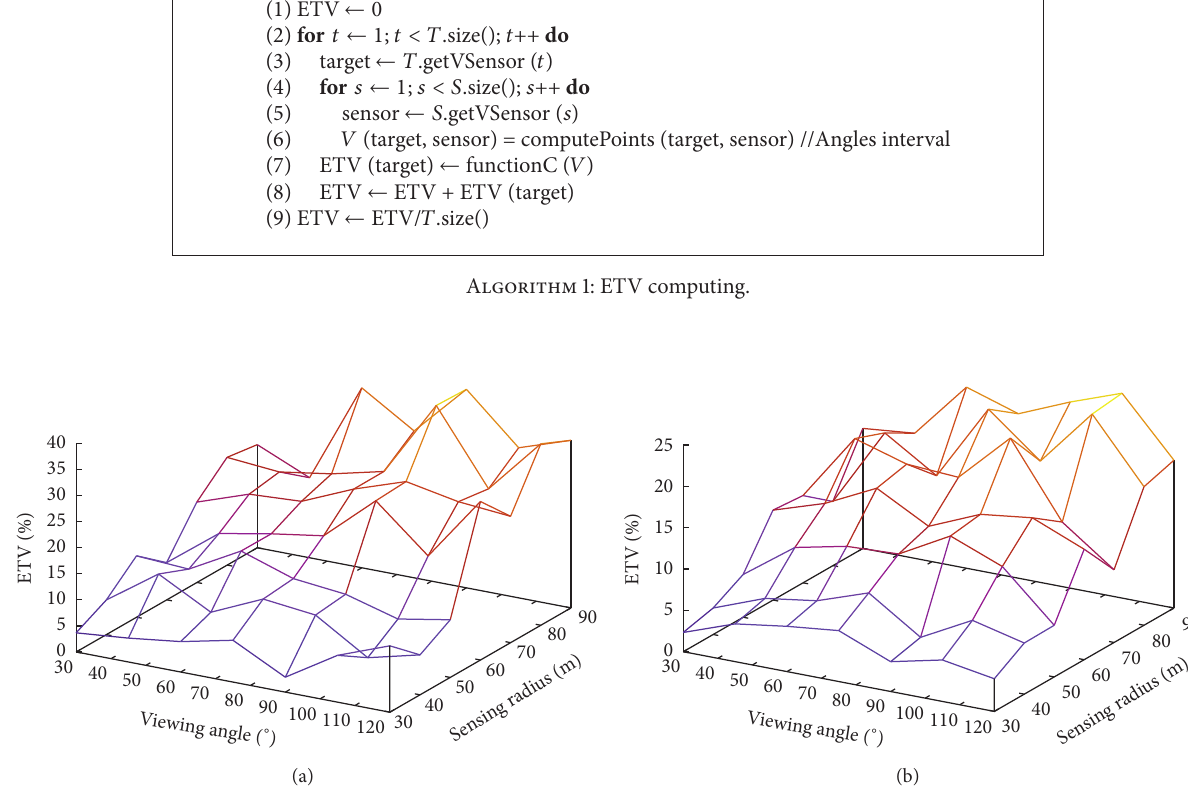
Figure 6: ETV after random deployment: (a) 5 targets with 𝑅 (𝑡) = 20 ; (b) 5 targets with 𝑅 (𝑡) = 50 .